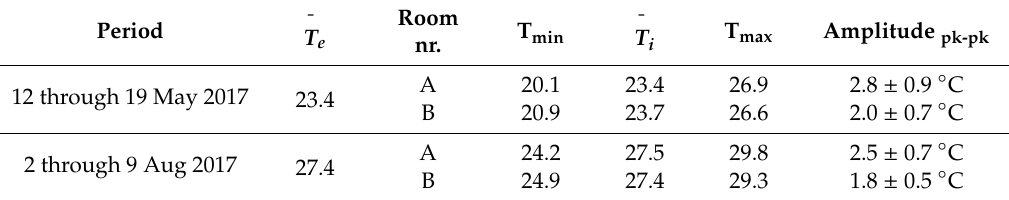
Table 6. Temperatures and peak-to-peak amplitudes of indoor temperatures in the two rooms during the two time periods in May and August 2018. Room Period ¯ T Period 𝑻(cid:3365) 𝒆 Room nr. e